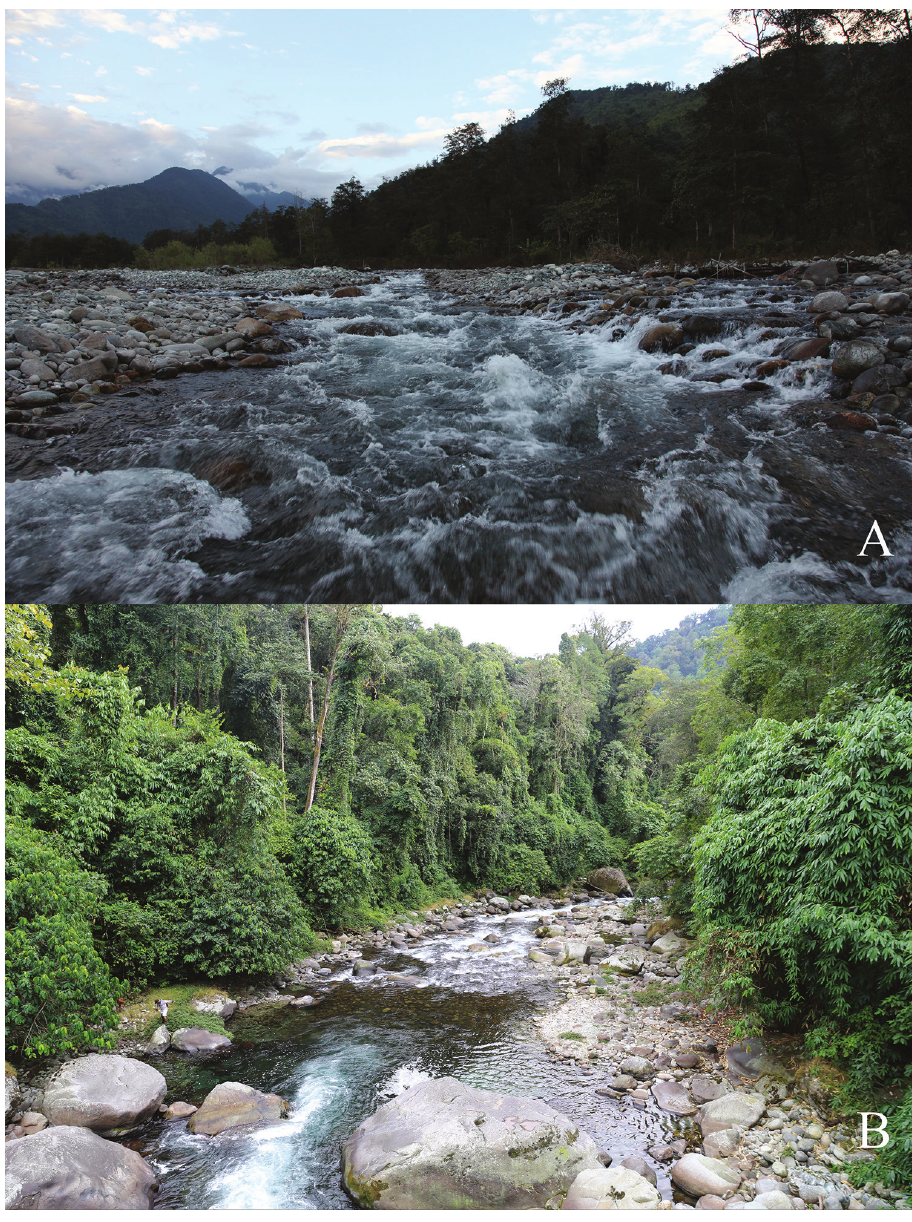
Figure 6. Habitat of Oreoglanis hponkanensis . A Zeyar Stream, Mali Hka drainage, Hponkanrazi Wild- life Sanctuary, north Myanmar B Monlar Stream, Mali Hka drainage, Hponkanrazi Wildlife Sanctuary, north